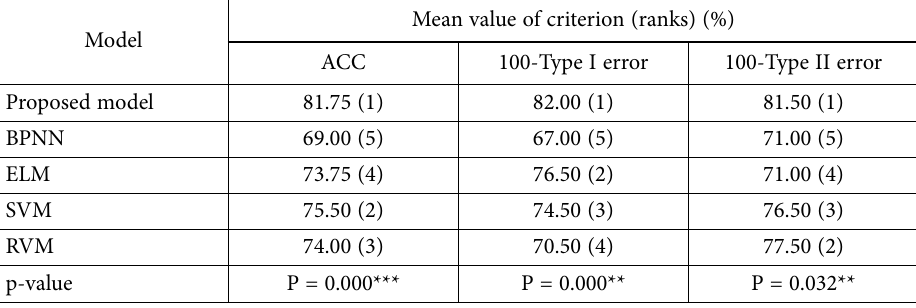
Table 8. The Friedman test results (performance rank determined by ROA)